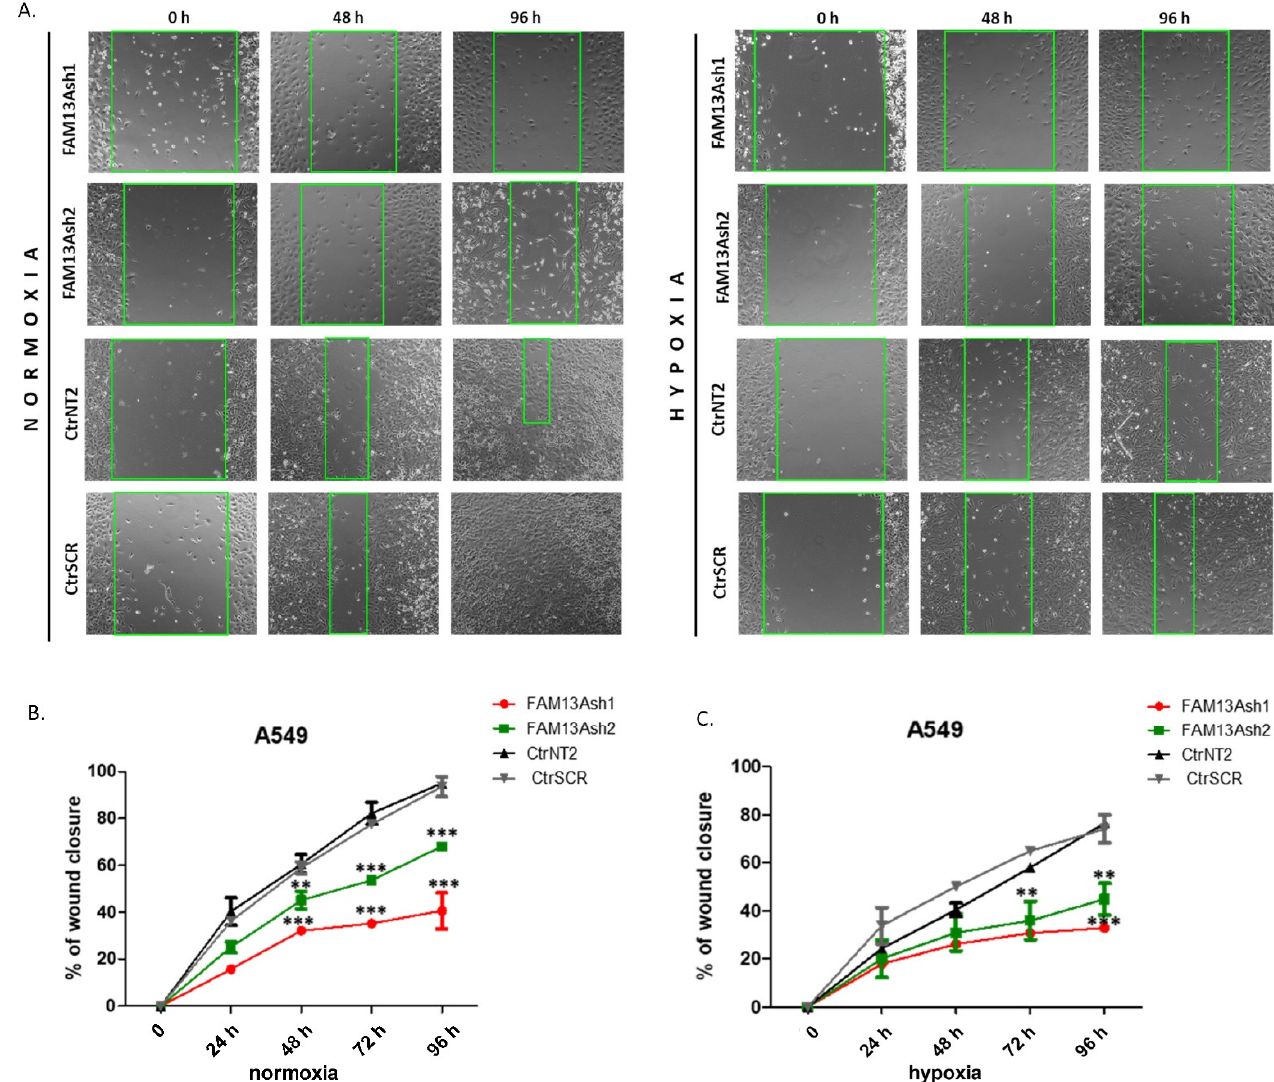
Figure 3. Knockdown of FAM13A suppresses A549 lung cancer cell migration. The migration of A549 cells with FAM13A knockdown and controls was monitored for 96 h under normoxia and hypoxia conditions. The inserts were used to generate a defined gap for measuring the migratory rates. Cell suspension in low serum media was added to the open end at the top of the insert. The cells were incubated overnight to form the monolayer. After 24 h inserts were removed from wells. The wound healing closure was visualized under a light microscope, images were taken in 24 h intervals. ( A ) Representative microscopy images of the wound-healing assay (magnification, ×10). Images of FAM13A depleted cells (FAM13Ash1) and control (CtrSCR) cells, cultured under normoxia ( left panel) and hypoxia ( right panel), were taken at the time 0 h, 48 h and 96 h after wounding. ( B , C ) Wound confluence (% of wound closure) was measured at 5 time points (0 h, 24 h, 48 h, 72 h, 96 h) after wound generation for FAM13A knockdown A549 cells: FAM13Ash1 (red), FAM13Ash2 (green) and controls: CtrNT2 (black), CtrSCR (grey) cultured in normal oxygen concentration ( B ) and under hypoxia ( C ). Data is expressed as the mean ± SEM of n = 3 exp. A two-way ANOVA with Bonferroni posttest was used for statistical analysis. p values ≤ 0.05 indicate a significant difference, as marked by an asterisk (** p < 0.01, *** p < 0.001). The experiments were performed in triplicate and repeated three times.